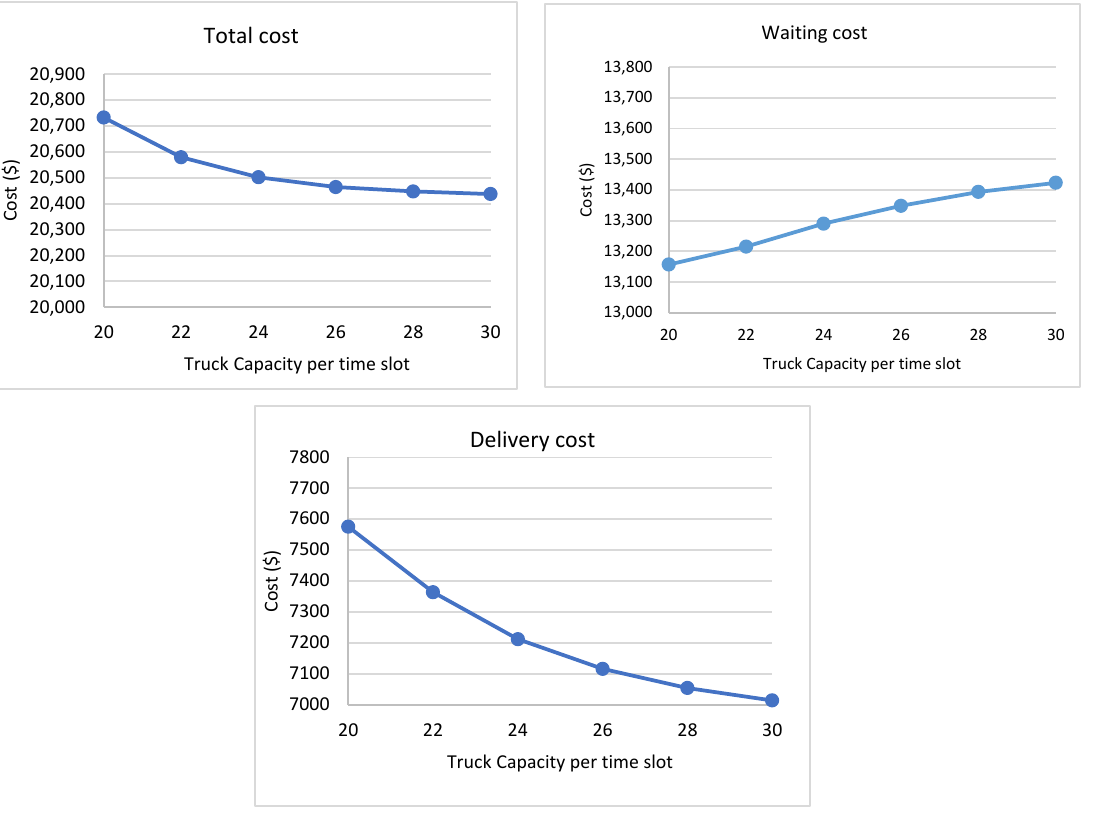
Figure 6. The variation of the objective function value and other cost terms through the sensitivity analysis experiment.